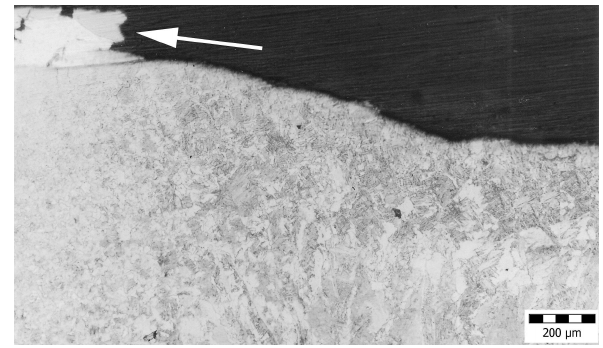
Figure 9: Microstructure of the heat affected zone of sample C with presence of